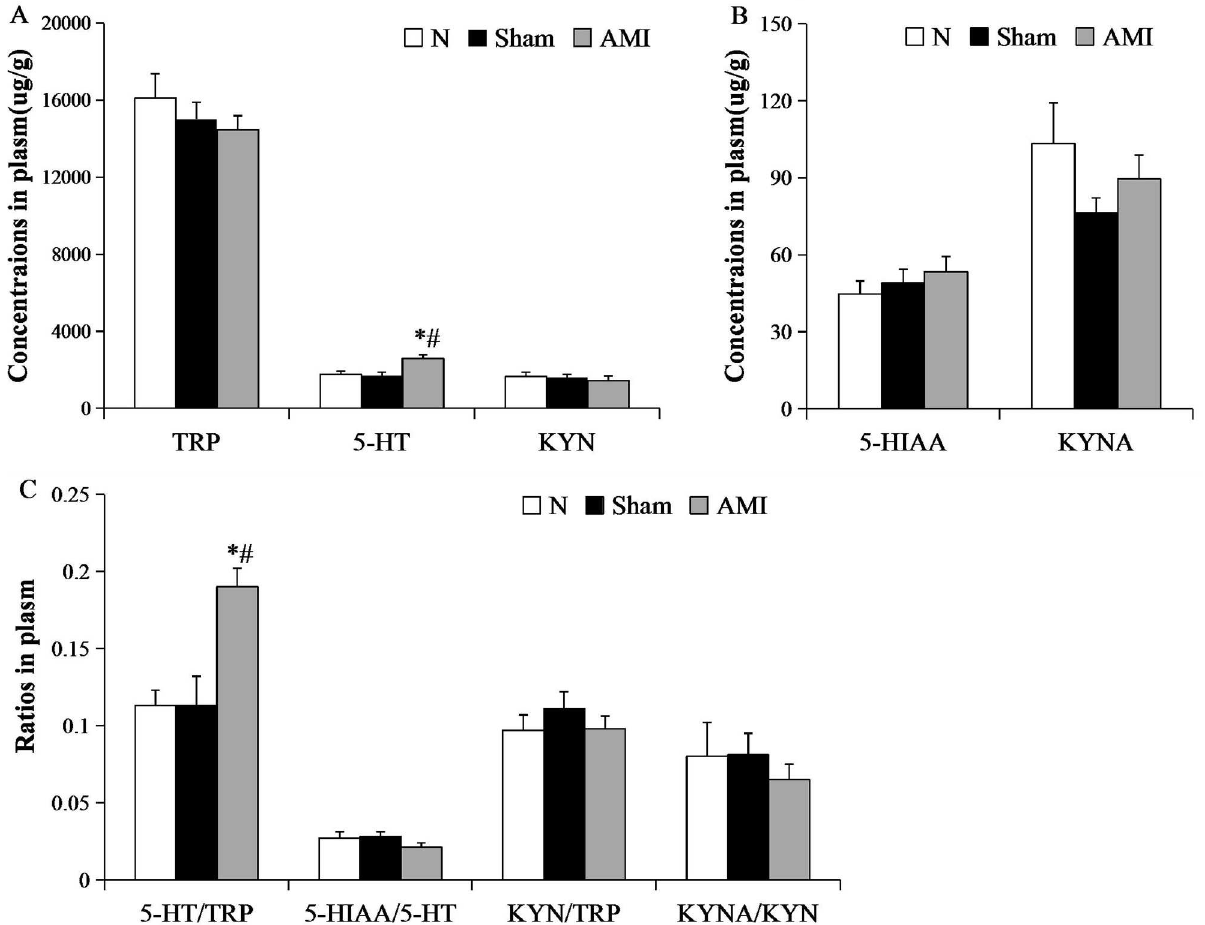
Fig 6. Concentrations of TRP and its metabolites in the plasma using HPLC. (A) Concentrations of (A) tryptophan (TRP), 5-HT, and kynurenine(KYN); (B) 5-hydroxyindoleacetic acid (5-HIAA) and kynurenicacid (KYNA); (C) the ratios of 5-HT/TRP, 5-HIAA/5-HT, KYN/ TRP, KYNA/KYN. Each bar representsmean ± S.E.M. of each group of mice (n = 8 per group). * P < 0.01 vs. N group; # P < 0.01 vs. Sham